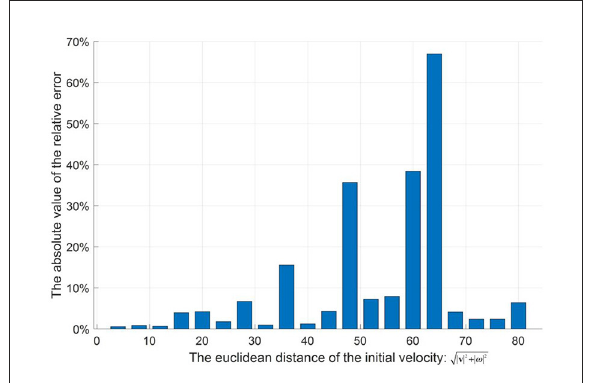
FIGURE2 The effect of parameter uncertainty on flight trajectory.